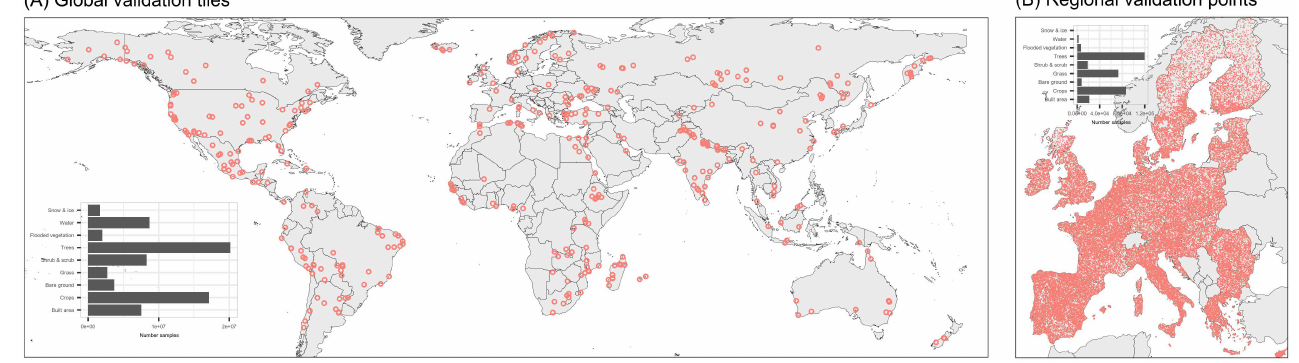
Figure 3. Distribution of the global ( A ) and regional ( B ) reference data locations. Locations in ( A ) represent Sentinel-2 image tiles of 510 × 510 pixels, which were manually annotated ex situ. Locations in ( B ) are grid points sampled in situ in the LUCAS area survey. Inset bar plot shows the number of reference samples per LULC